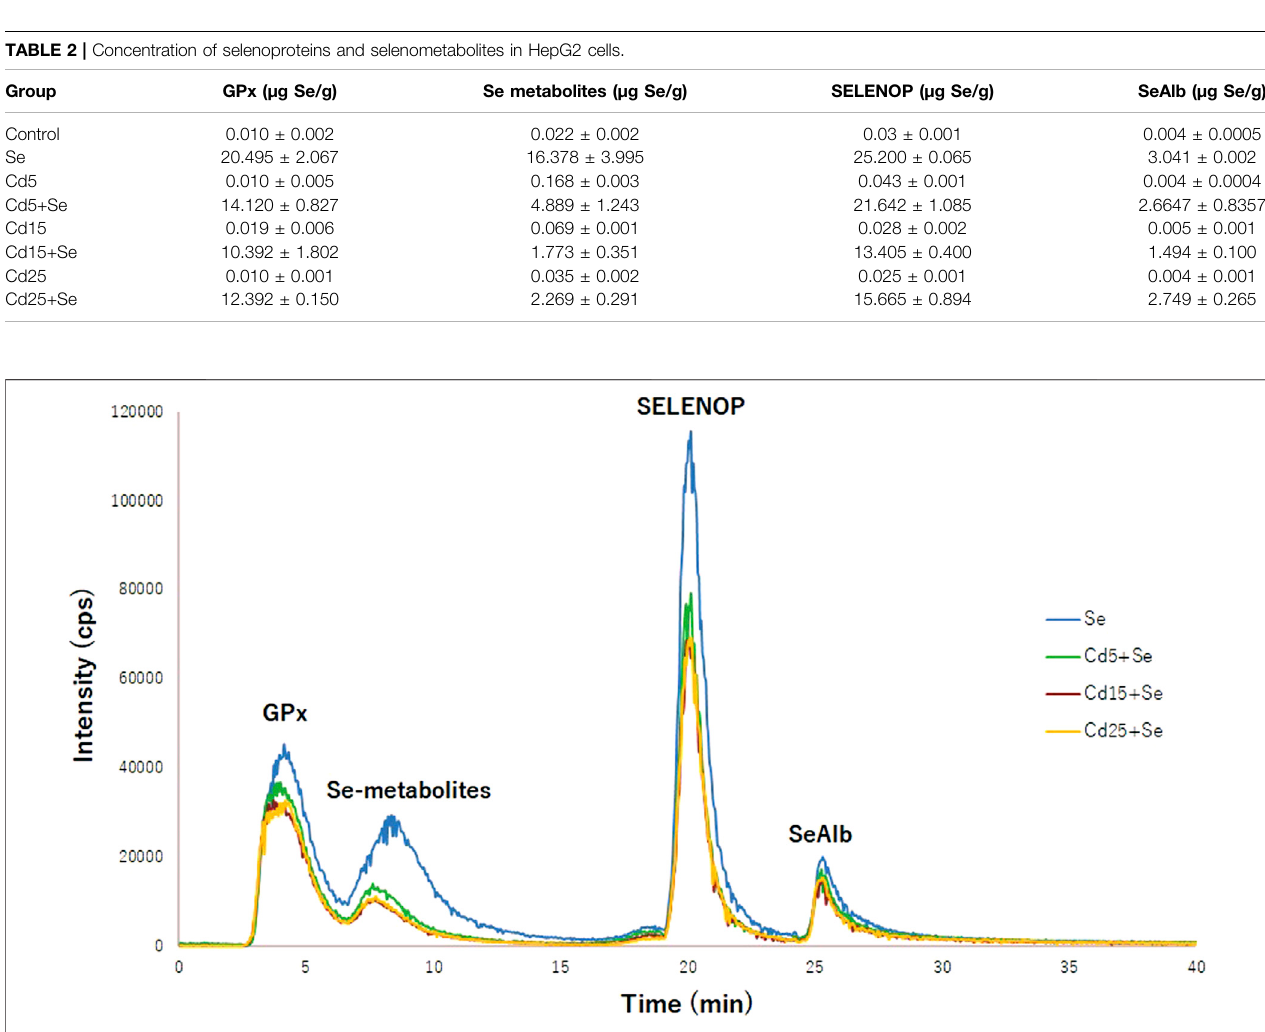
FIGURE3| Chromatogramofselenoproteinsobtainedby2D-HPLC-SEC-AF-SUID-ICP-QqQ-MS.Blue(Segroup);green(Cd5+Segroup);red(Cd15+Segroup); yellow (Cd25+Se group).